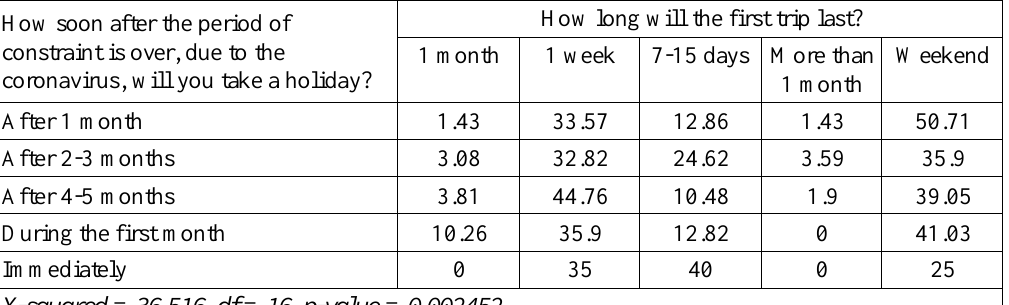
Table 5: Two-Way Table: Duration and How soon after the Period of Constraint is over, due to the Coronavirus, will you take a Holiday? (second wave) How long will the first trip last? How soon after the period of constraint is over, due to the 1 month 1 week 7-15 days More than Weekend coronavirus, will you take a holiday? 1 month After 1 month 1.43 33.57 12.86 1.43 50.71 After 2-3 months 3.08 32.82 24.62 3.59 35.9 After 4-5 months 3.81 44.76 10.48 1.9 39.05 During the first month 10.26 35.9 12.82 0 41.03 Immediately 0 35 40 0